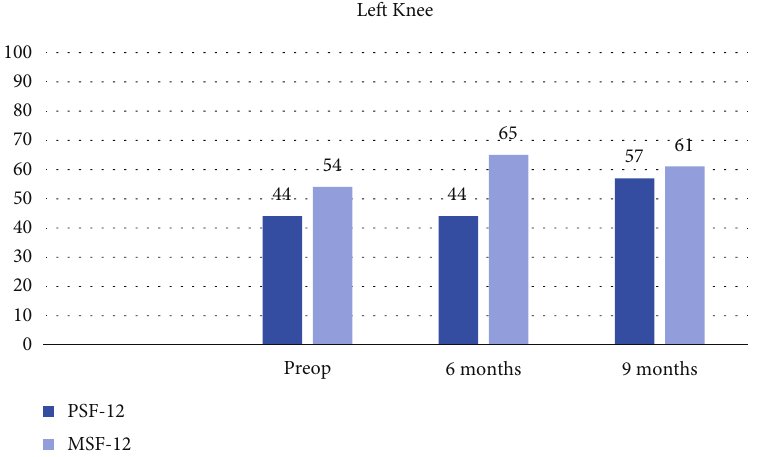
Figure 16: Patient short form and multisource